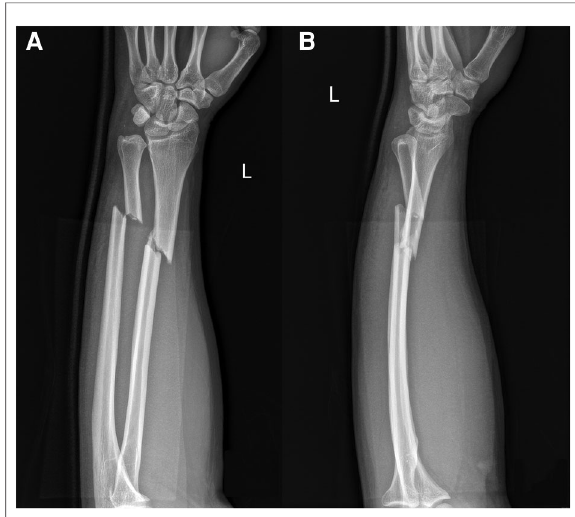
FIGURE 1 X-ray images ( A,B ) of the left forearm showed both bone forearm fractures with marrow